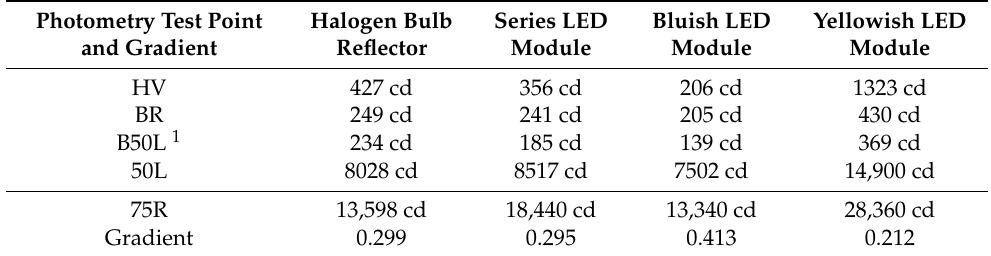
Table 2. Left light samples and their main photometric values as per ECE